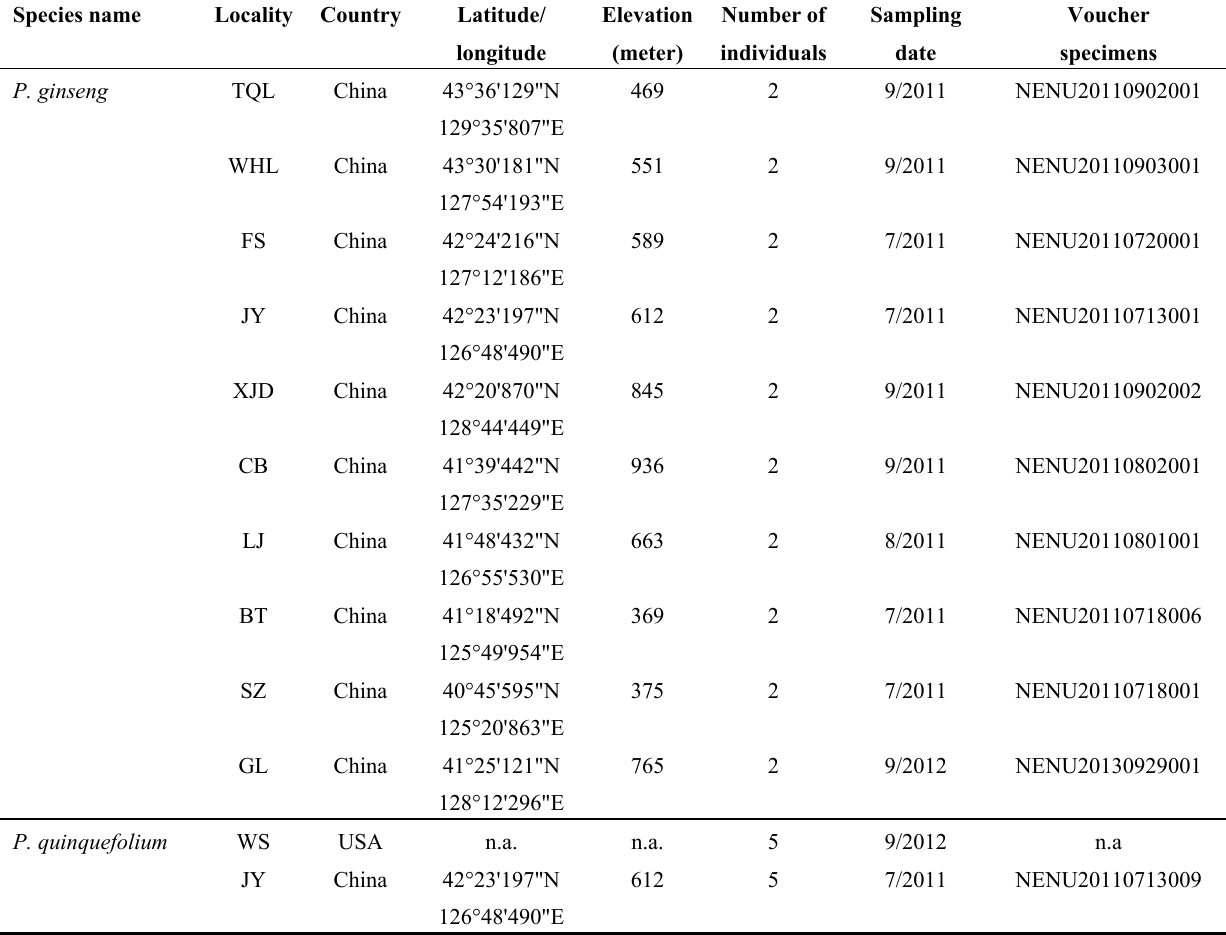
Table 3. Details of localities sampled from the field in this study and number of individual sequenced for each locus in each